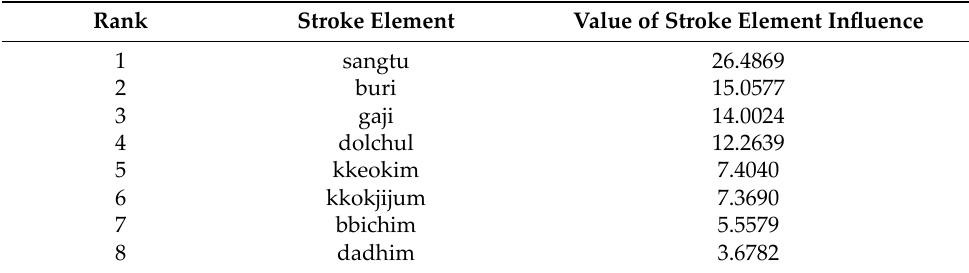
Table 11. Existing stroke element influence values and rankings in previous